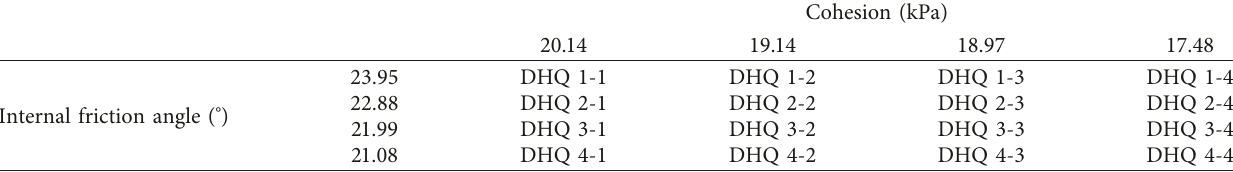
Table 4: Names of the 16 groups of c and ϕ for Dahua